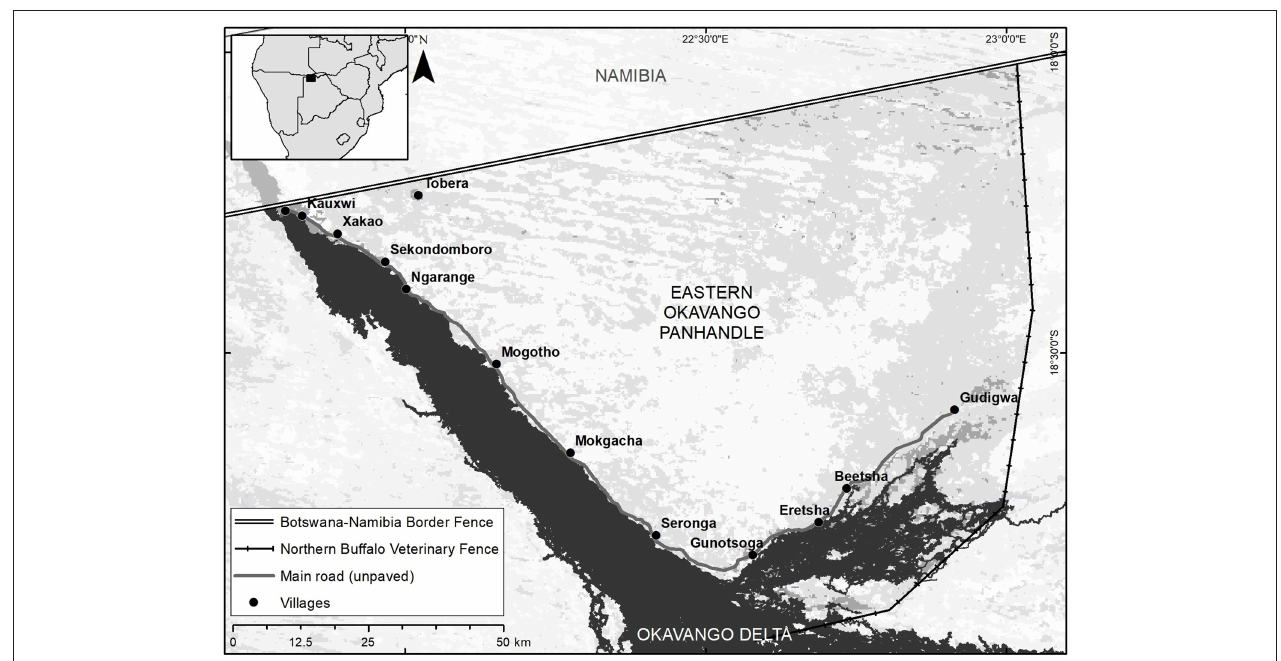
FIGURE 1 | Map of the study region in the Eastern Okavango Panhandle, Botswana.